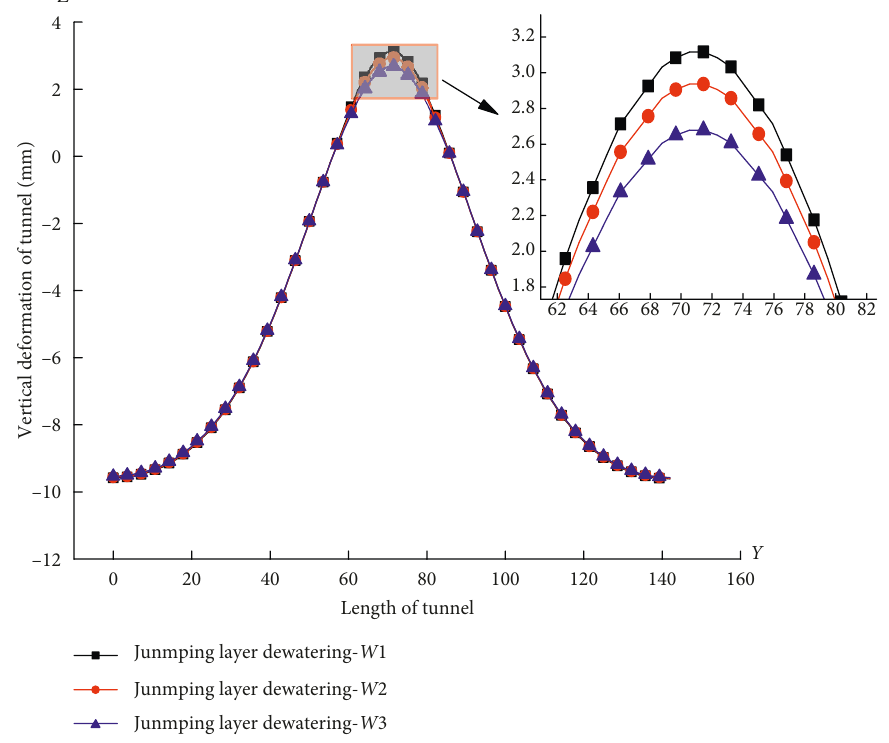
Figure 14: Tunnel deformation under different excavation methods with dewatering of jumping layer.